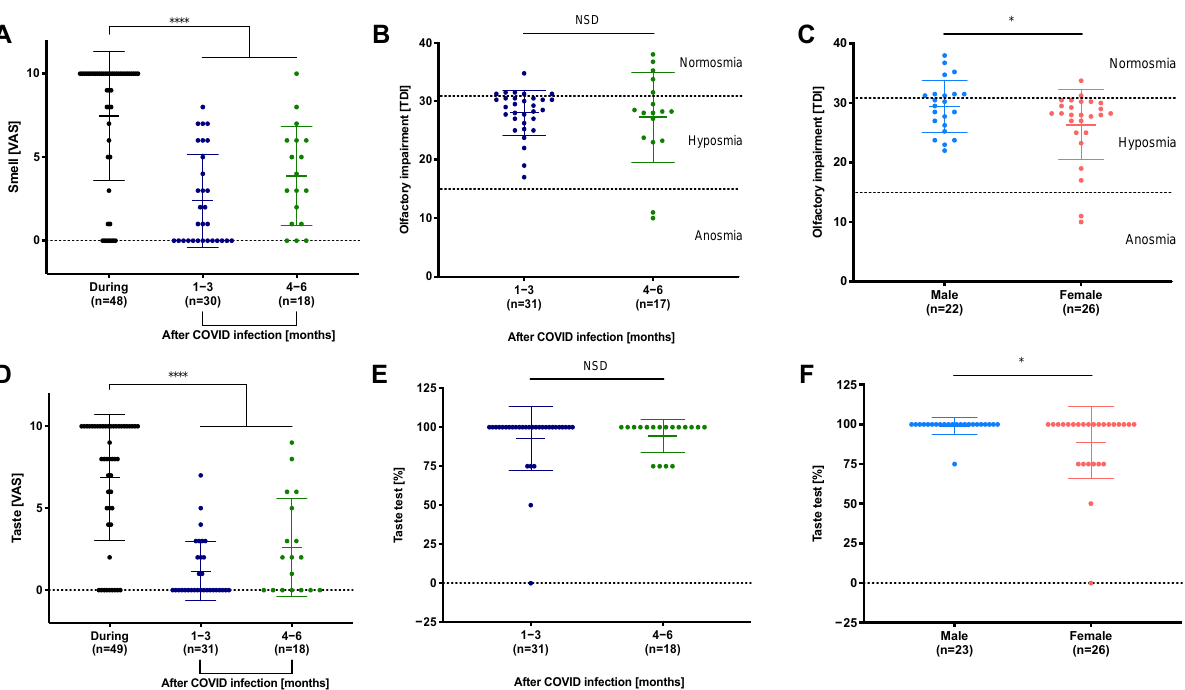
Figure 1. Impacts of COVID-19 on the olfactory and gustatory systems. Patients categorized their smell and taste dysfunction on a VAS (0—no impairment; 10—complete smell/taste loss) retrospectively for the time during COVID-19 and for 1–6 months after COVID-19. ( A ) Self-assessed impact on smell during and after COVID-19. The sense of smell was strongly impaired during COVID-19 and improved in the initial 6 months following COVID-19. ( B ) Olfactory impairment was measured using Sniffin’ Sticks to determine TDI scores. Most subjects suffered from hyposmia during the initial 6 months after COVID-19. ( C ) Women showed significantly stronger olfactory impairment than men. ( D ) Self-assessed taste dysfunction during infection and within the initial 6 months after COVID-19. The sense of taste partially recovered in the initial 6 months after COVID-19. ( E ) Gustatory impairment was detected via taste test and is shown as a percentage. Most patients showed fully recovered gustatory function. ( F ) Women were significantly more often affected by taste dysfunction than men; n: number of patients; p -values below 0.05 were considered significant (* p < 0.05, **** p <